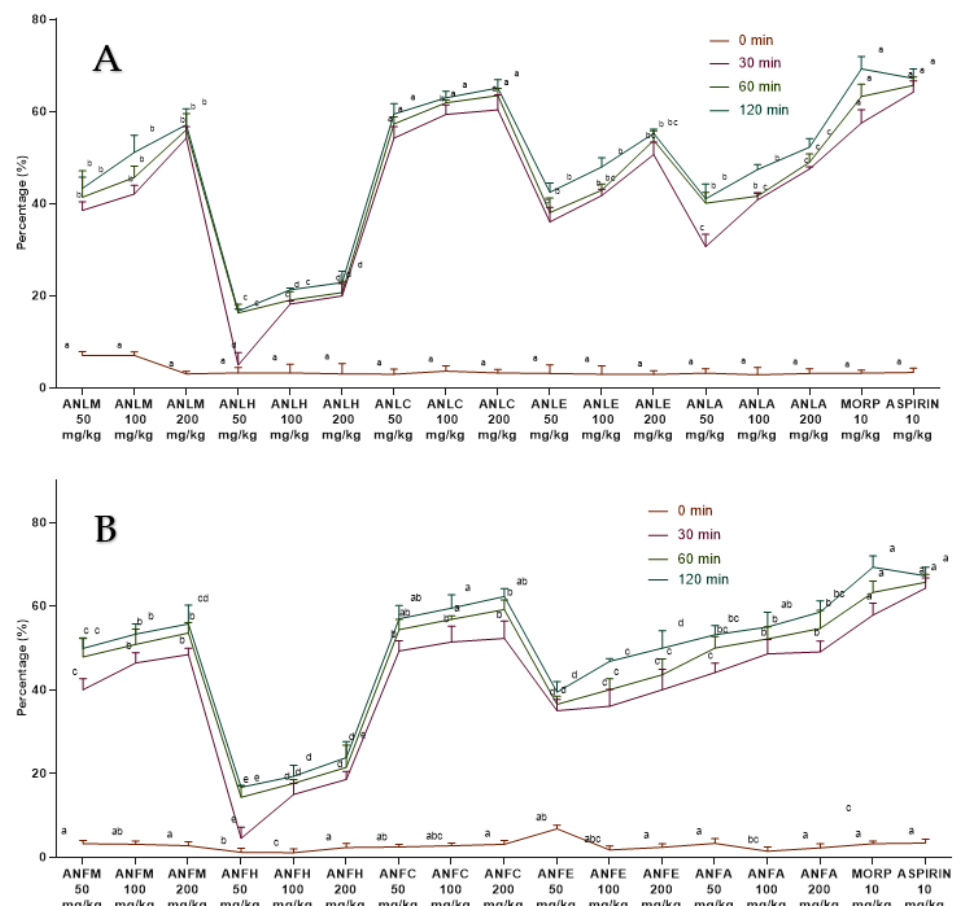
Figure 5. Percentage inhibition of A. nitida on hot plate test in rats ( A ) A . nitida leaves methanolic extract (ANLM), A . nitida leaves n-hexane fraction (ANLH), A . nitida leaves chloroform fraction (ANLC), A . nitida leaves ethyl acetate fraction (ANLE), A . nitida leaves aqueous fraction (ANLA) and ( B ) A . nitida fruit methanolic extract (ANFM), A . nitida fruit n-hexane fraction (ANFH), A . nitida fruit chloroform fraction (ANFC), A . nitida fruit ethyl acetate fraction (ANFE), A . nitida fruit